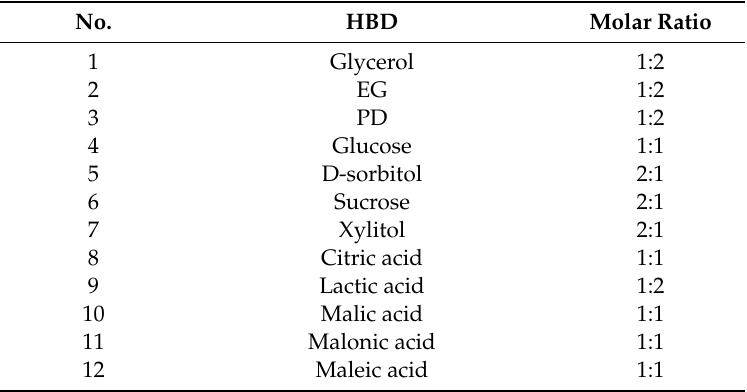
Table 1. List of the prepared ChCl-based deep eutectic solvents (DESs). No. HBD Molar